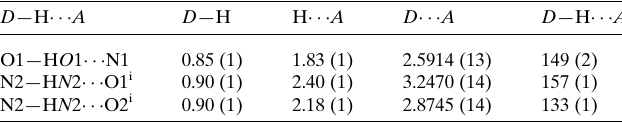
Table 1 Hydrogen-bond geometry (A˚ , (cid:4) ).